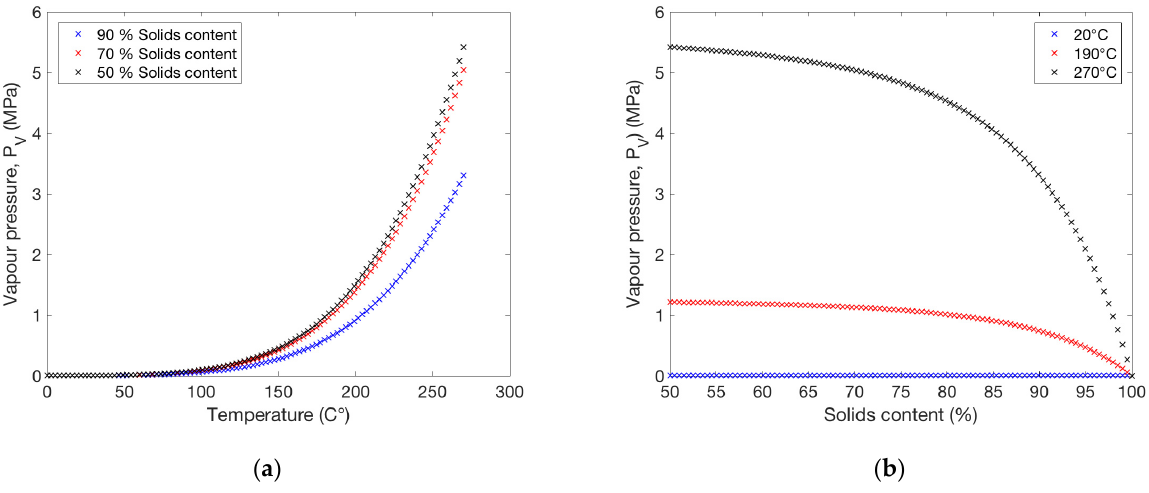
Figure A1. ( a ) Vapour pressure as a function of temperature for three different levels of solids content, 90%, 70%, and 50%. ( b ) Vapour pressure as a function of solids content for three different temperature levels, 20 °C, 190 °C, and 270 °C. Table A1. The values of the parameters used for plotting the vapour pressure as a function of tem- perature and solids content in Figure A1.